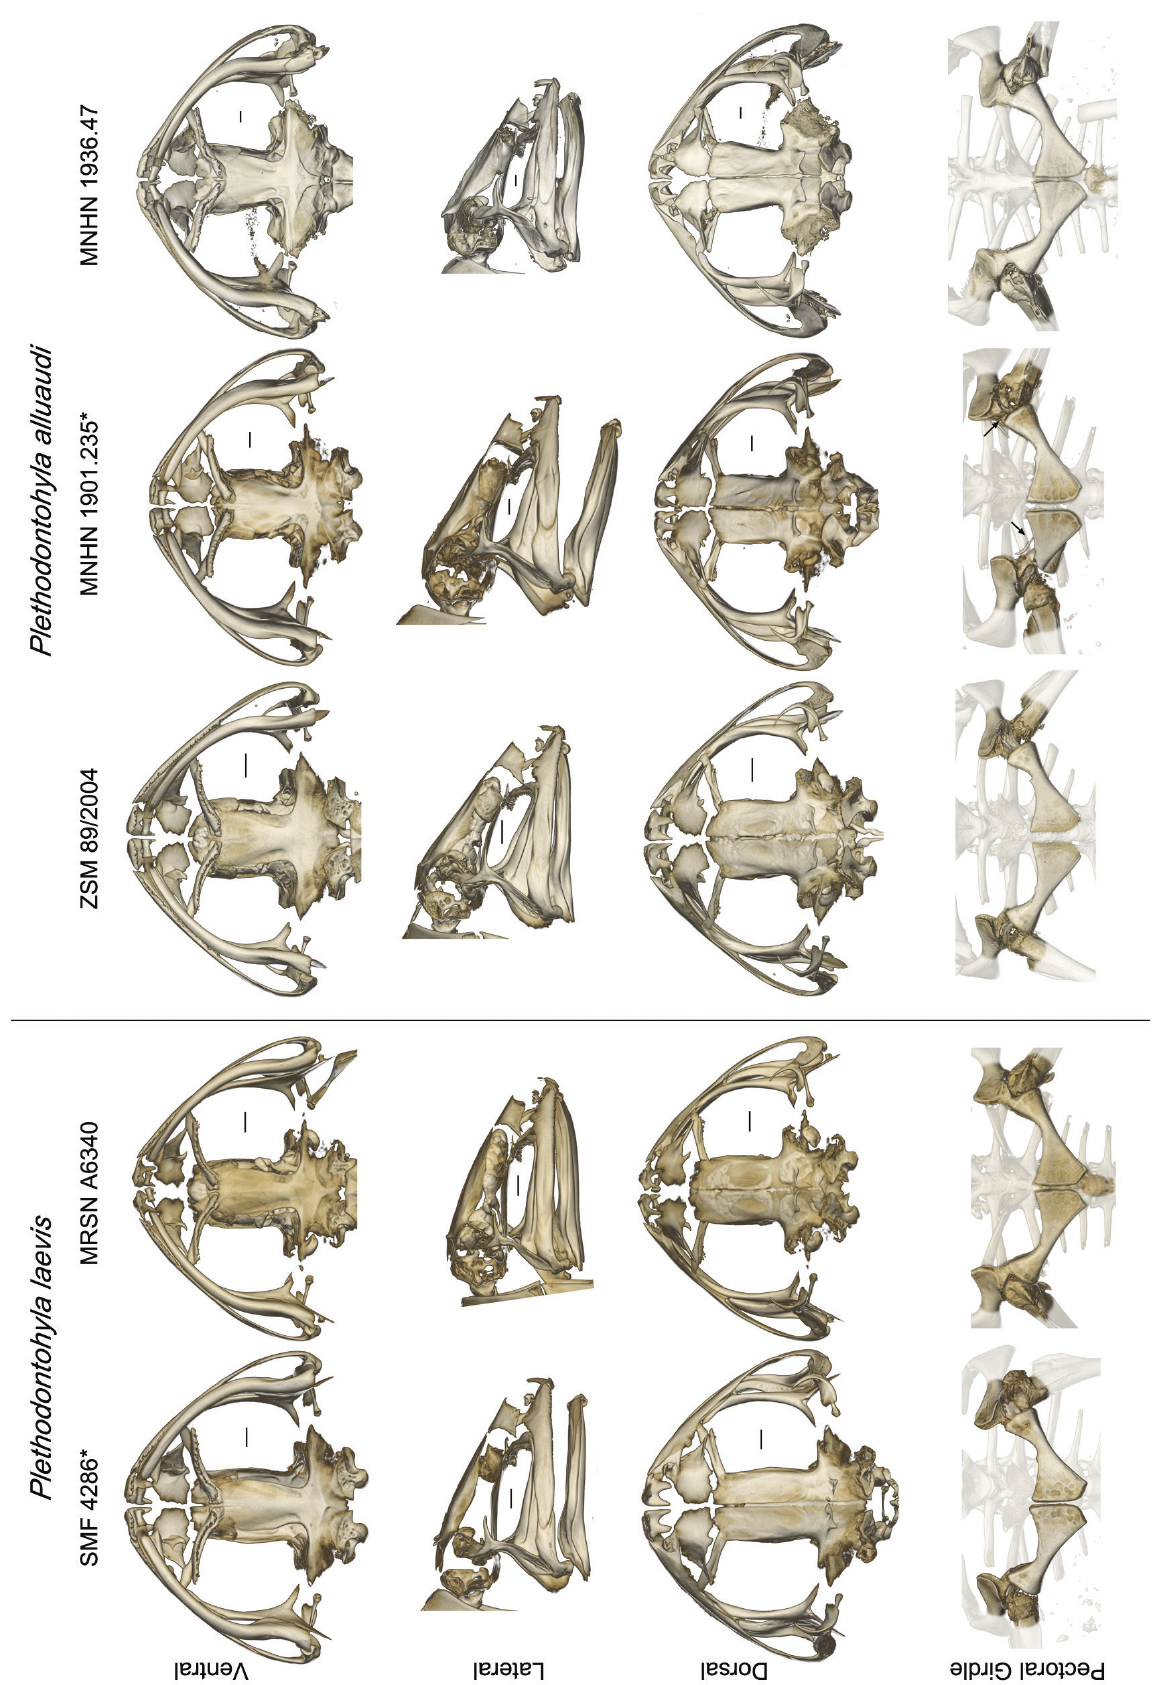
Figure 6. Skull and pectoral girdle morphology of Plethodontohyla alluaudi and P. laevis . Asterisks indicate the holotypes of each species. Arrows on the pectoral girdle of P. alluaudi MNHN 1901.235 indicate the clavicles. Scale bars indicate 1